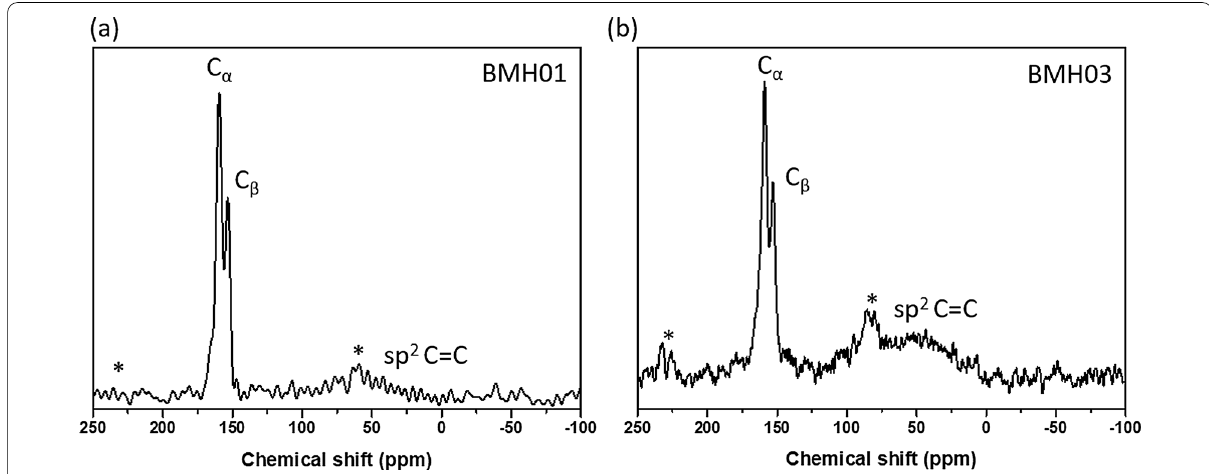
Fig. 5 Solid‑state 13 C MAS NMR of a BMH01 and b